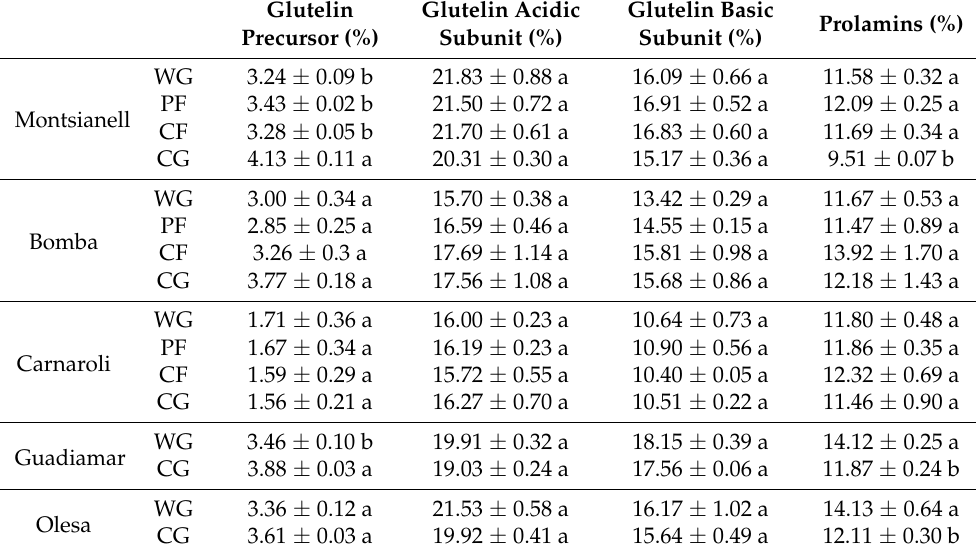
Table 3. Relative percentages of various storage protein fractions of the rice grains for each cultivar. Values are presented as mean ± SEM. Different letters between groups within a cultivar indicate significant differences for that specific fraction ( p < 0.05). WG = whole grain. PF = pearl fraction. CF = crystalline fraction. CG = chalky grain. Glutelin Glutelin Acidic Glutelin Basic Prolamins Precursor (%) Subunit (%) Subunit (%)